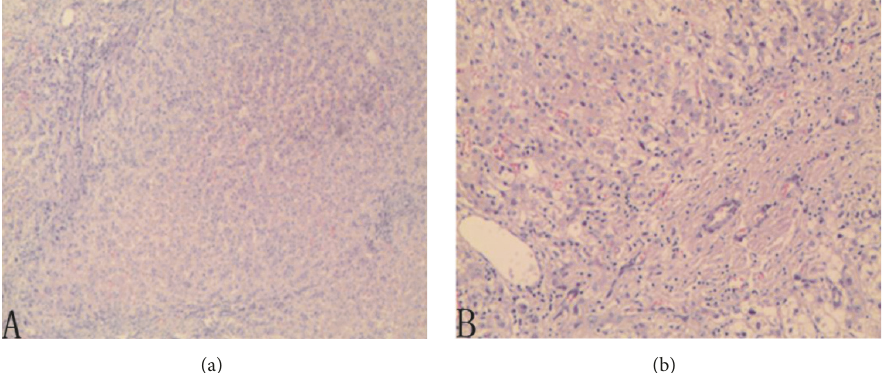
Figure 3: (a, b) Pathologically, the lesion was nodular in appearance and lacked a normal hepatic lobule texture, with absence of normal hepatic veins and bile ducts, while multiple fibrous connective tissues and chronic inflammatory cells scattered